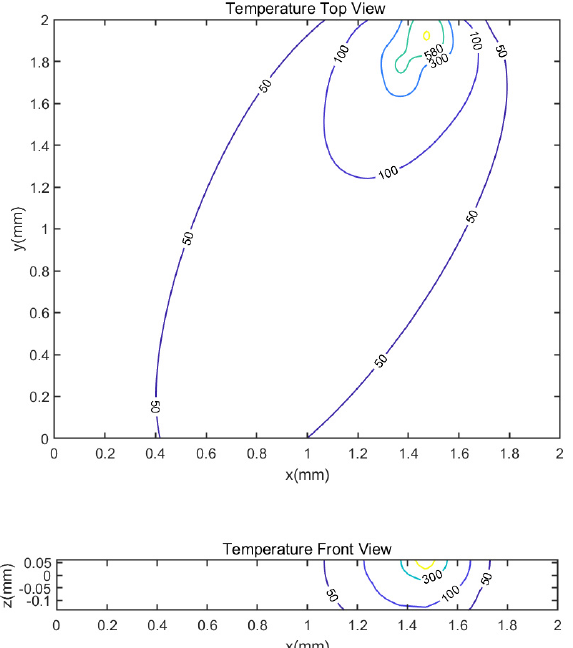
Figure 6. Predicted temperature profile in top and front view with laser power 195 W, scan speed 700 mm/s, hatching space 0.17 mm and layer thickness 30 µ m. The rotation angle between two successive layers is 67 degrees.